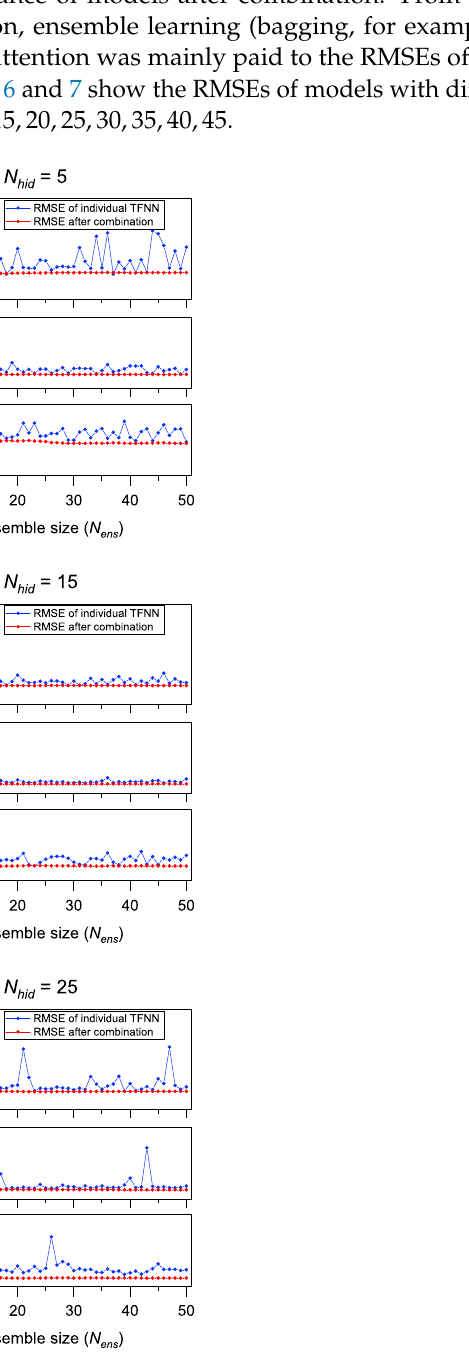
Figure 6. RMSEs of different modeling schemes after combination under different ensemble sizes ( N hid = 5,10,15,20,25,30). Blue dots are the RMSEs of individual randomly placed TFNNs; red dots are the RMSEs of results after combining N ens randomly selected